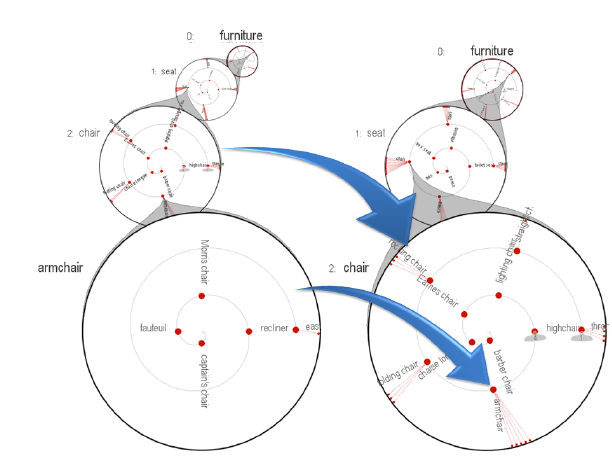
Figure 8. Clicking on the ‘chair’ node circle (left) makes it the node of interest (NOI) (right). The current NOI, ‘armchair’, (left) is reduced to its child position in the ‘chair’ circle. Ancestral elision is not required